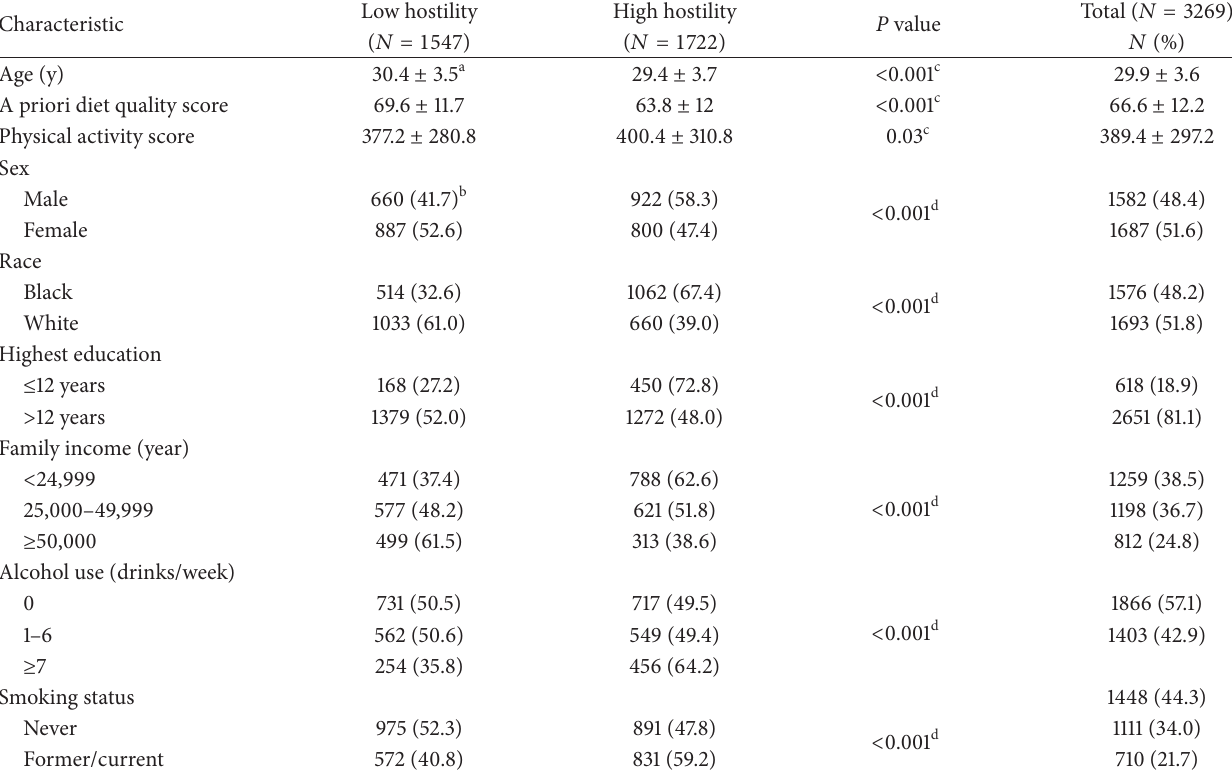
Table 1: Demographic and behavioral distribution of participants by levels of hostility at baseline (Year 5), CARDIA, 1985.